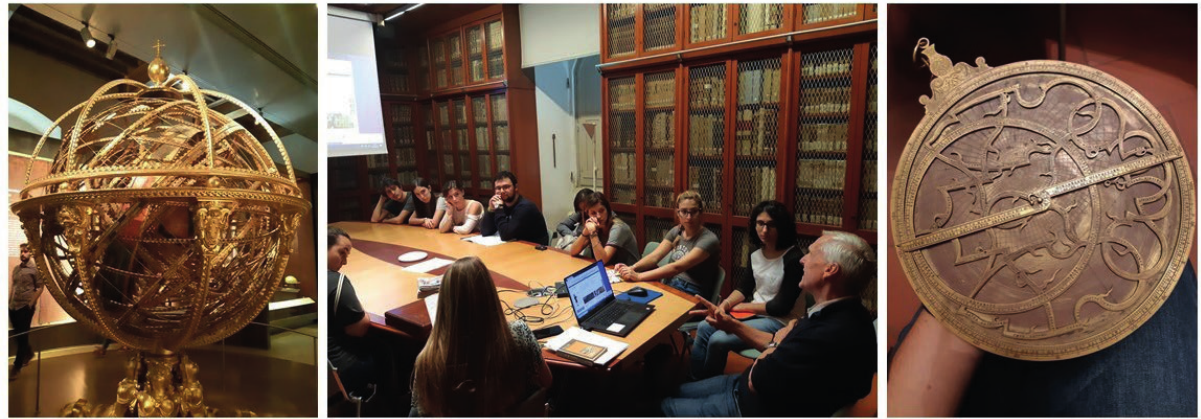
Figure 1. Pictures taken during the visit at the Museum ‘Galileo’ under the guide of the curator of the educational activities at the science museum, dr. Andrea Gori. (photo credit: Valentina Domenici).